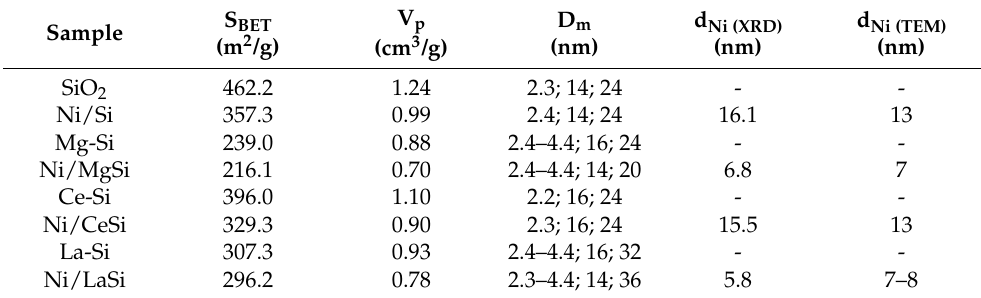
Table 1. Textural properties of the